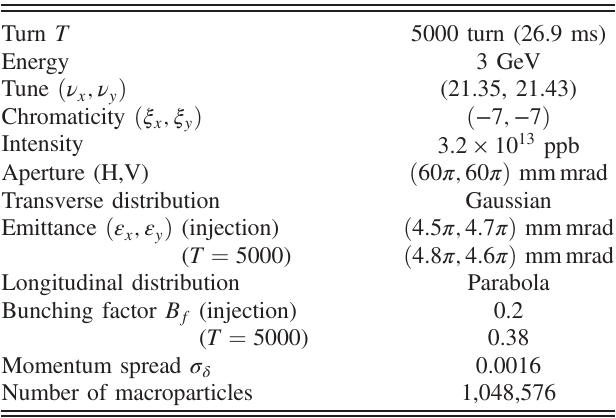
TABLE II. Parameters of the tune spread